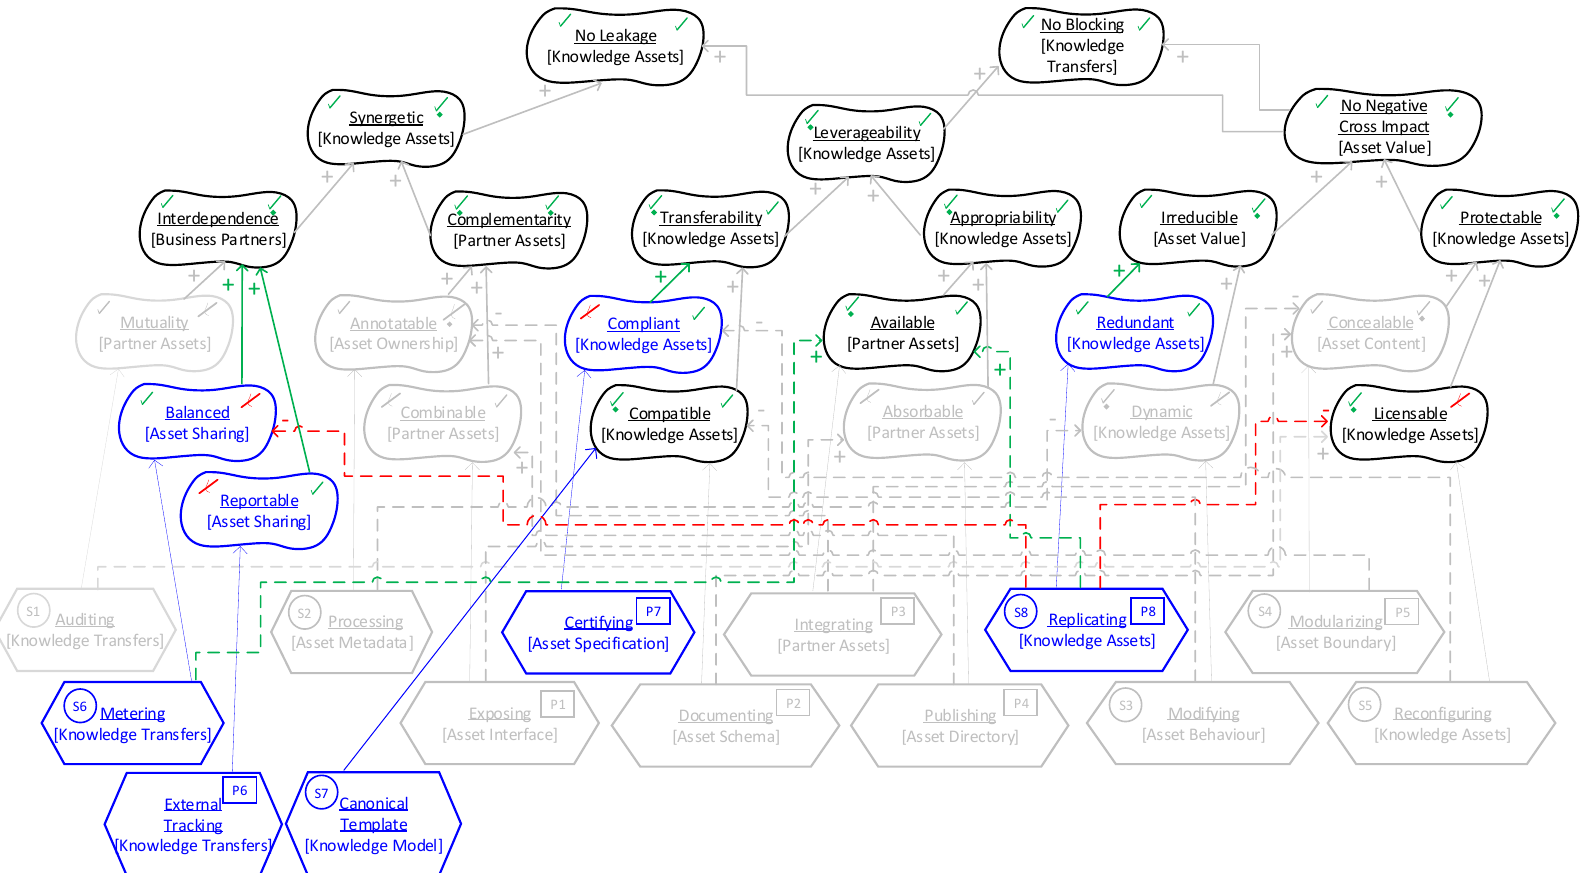
Figure 5 . Goal model of To-Be scenario representing knowledge sharing goals and potential tasks, synthesized from sources listed in Table 1, Table 2, Table